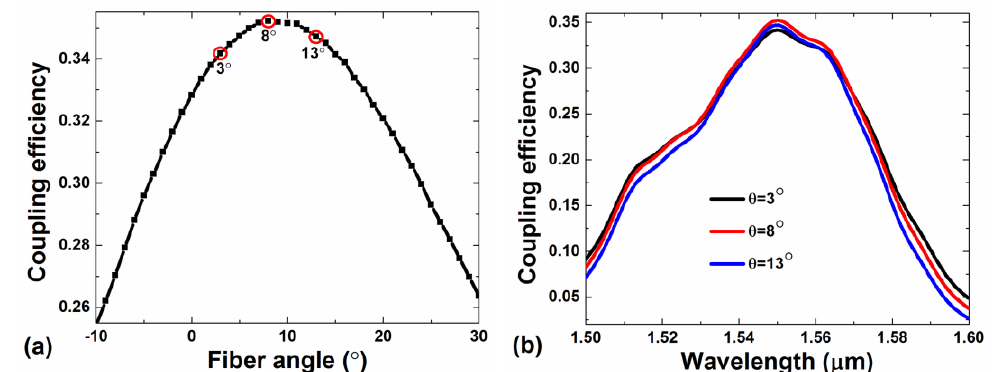
Figure 5. ( a ) Coupling efficiency as a function of fiber angle, which is relative to the surface that is perpendicular to the Si substrate. ( b ) Coupling efficiency as a function of wavelength for different fiber angles. ( T = 2.1 μm L x = 3.5 μm, Ly = 0 μm, Λ = 0.64 μm, and DC = 0.829).